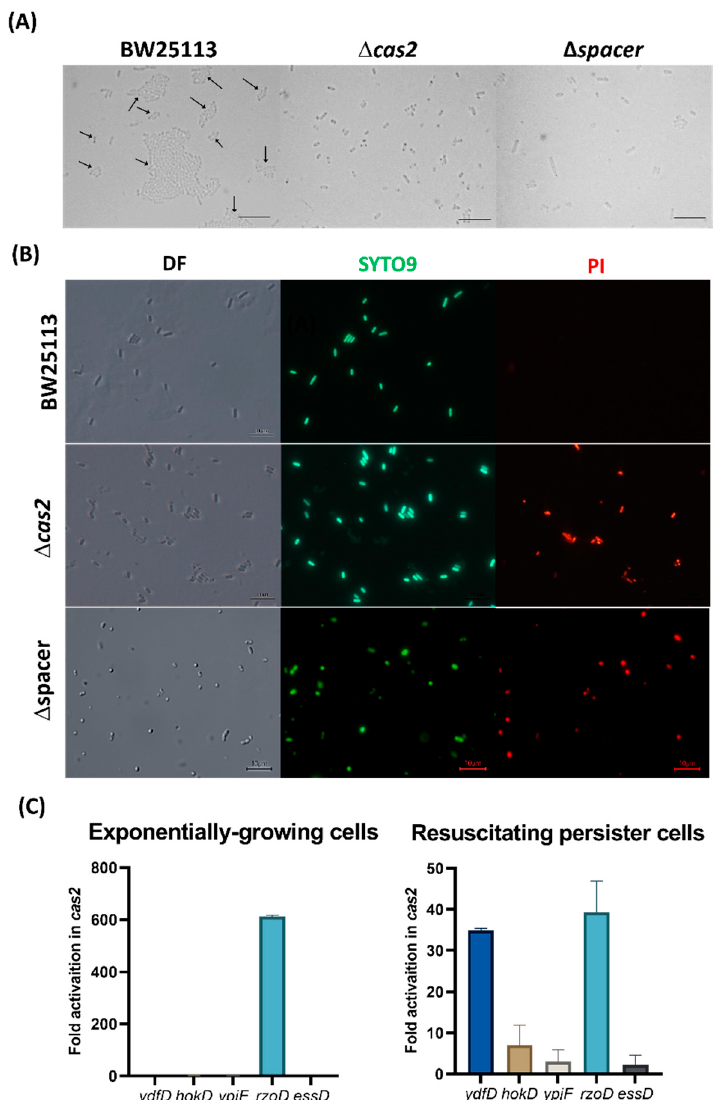
Figure 1. Inactivating CRISPR-Cas eliminates persister cell resuscitation by activating cryptic prophage lytic proteins, causing cell death. ( A ) Single-cell persister resuscitation for wild-type BW25113, the cas2 mutant , and the ∆ spacer mutant after 6 hours on 0.4 wt% glucose minimal medium. Black arrows indicate cells that resuscitate, and the scale bar indicates 10 µ m. Cells were observed using light microscopy (Zeiss Axioscope.A1). Representative results from two independent cultures are shown, and tabulated cell numbers are in Table S1. ( B ) LIVE/DEAD staining of resuscitating persister cells shows the cas2 and ∆ spacer mutations cause cell death. DF is dark field, SYTO9 is a membrane permeable stain for nucleic acids (green), and PI is propidium iodide, which is a membrane impermeable stain for the nucleic acids of dead cells (red). Representative results from two independent cultures are shown, and tabulated cell numbers are in Table S2. ( C ) The cas2 mutation derepresses the cryptic prophage lysis genes ydfD (in resuscitating persister cells) and rzoD (in both resuscitating persister cells and exponentially-growing cells). Five lytic genes from three cryptic prophages were checked by qRT-PCR: ydfD (Qin), hokD (Qin), ypjF (CP4-57), essD (DLP-12), and rzoD (DLP-12). Error bars indicate standard deviations from two independent cultures.